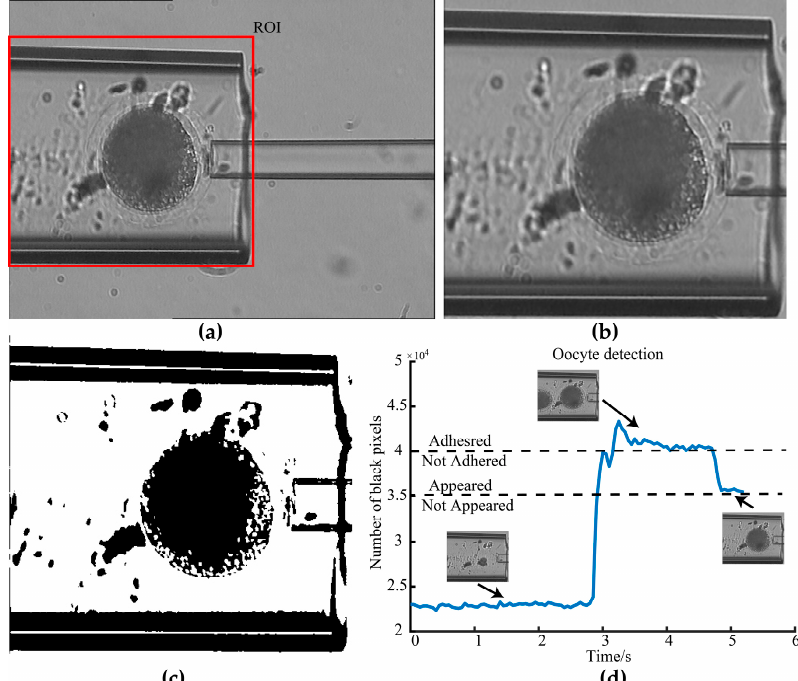
Figure 6. The process of oocyte detection. ( a ) The region of interest (ROI) selection. ( b ) The image after morphological opening. ( c ) The binary image. ( d ) The number of black pixels in the binary image in ROI during the delivery process.